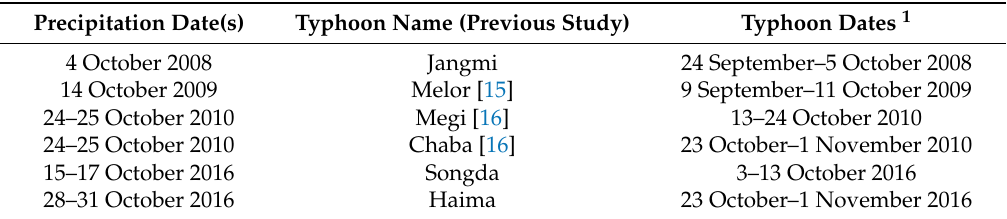
Table 1. Additional potential typhoon remnant-derived precipitation